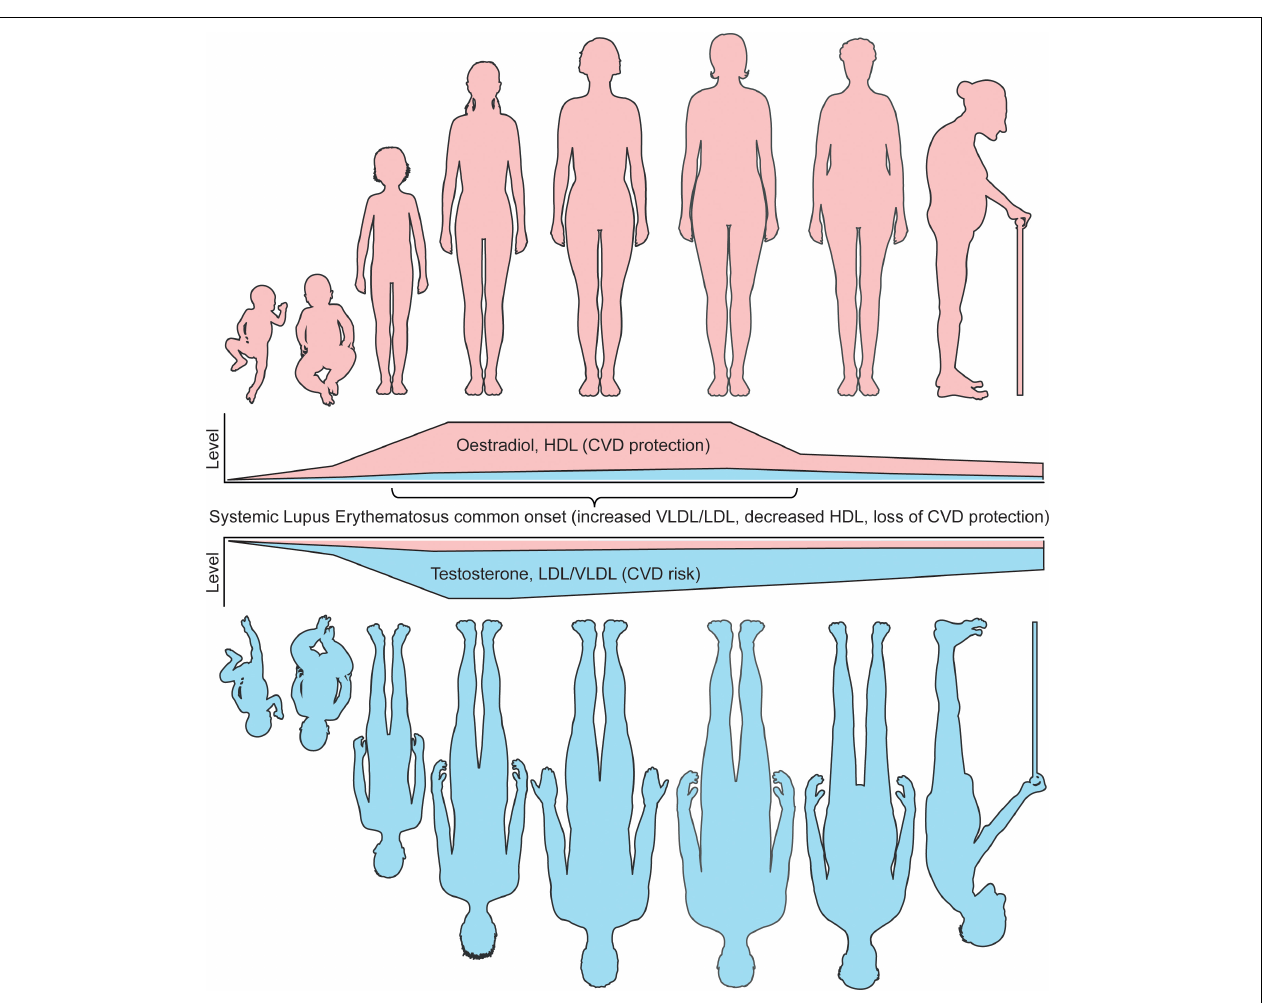
FIGURE 2 | Sex differences in lipoproteins and CVD risk coincide with age associated hormone changes. The levels of circulating sex hormones change throughout life. Pre-puberty, research has shown that girls and boys do not have differences in either atherogenic (VLDL/LDL) or atheroprotective (HDL) lipoproteins. Following the onset of puberty, oestradiol increases in young women, which in turn raises the level of circulating HDL, inferring a lower CVD risk compared to young men in healthy individuals. Post-pubertal young men, with increased testosterone and low oestradiol levels, develop a more atherogenic lipoprotein profile, inferring an increased CVD risk compared to young women in healthy individuals. Whilst age is an independent risk factor of CVD risk in both men and women, oestradiol and HDL remain high in women until menopause, where oestradiol dramatically reduces and CVD protection by HDL is less prominent. Despite this, the levels of HDL in women remain higher than men post-menopause. Older men do not experience this dramatic fall in sex hormones, however, the levels of testosterone do slowly reduce with age. A recent study has shown that sex hormone associated lipoprotein changes can be induced by cross sex hormones in young transgender individuals, supporting these CVD risk associated observations. In patients with SLE, a disease with most common onset in women of a childbearing age, where women represent around 90% of all patients, CVD protection in women is dramatically reduced due to dyslipideamia. This includes increased atherogenic lipoproteins and reduced HDL. It is speculated that this could be due to changes in levels or tissue sensitivity oestradiol, which drives inflammation and altered lipid metabolism. Understanding these fundamental differences in lipoproteins by sex will aid our mechanistic understanding of sexually dimorphic diseases and improve disease prevention and outcomes for CVD and autoimmune patients. This figure was produced using resources from Servier Medical Art, licenced under a Creative Common Attribution 3.0 Generic License.